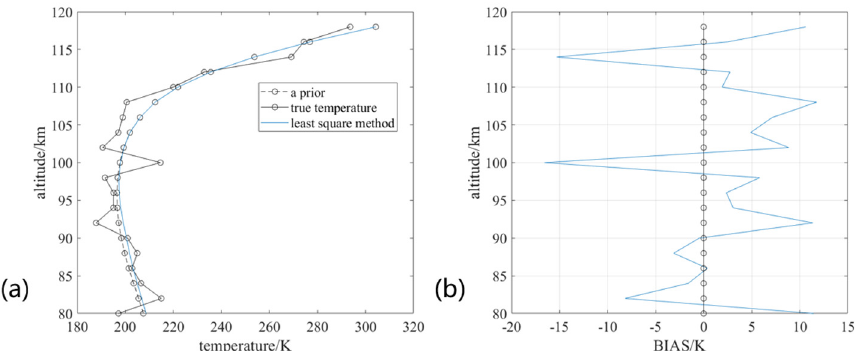
Figure 12. ( a ) Retrieval of atmospheric temperature in MLT region; ( b ) the bias between retrieved temperature and actual temperature at different tangent heights.